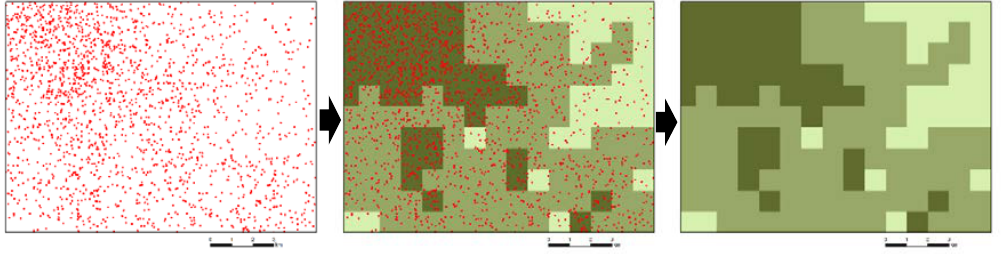
Figure 6. Dot coverage converted into a continuous surface by density of dots, where the darkest surface shows the highest density of dots.